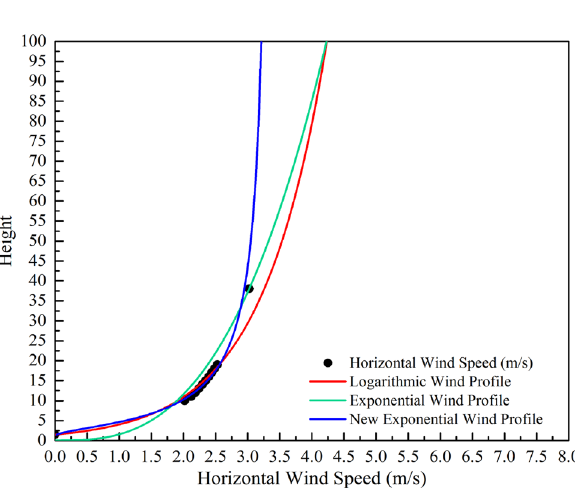
Figure 9. Various forms of wind speed power law changes.